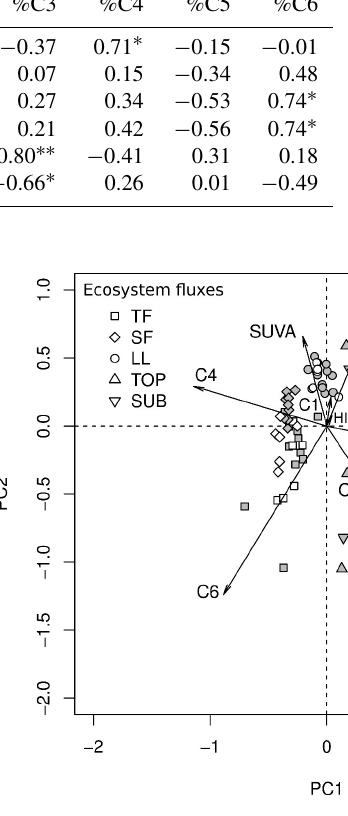
Figure 8. PCA plot of DOM composition variables (SUVA 254 , PARAFAC components C1–C6). TF: throughfall; SF: